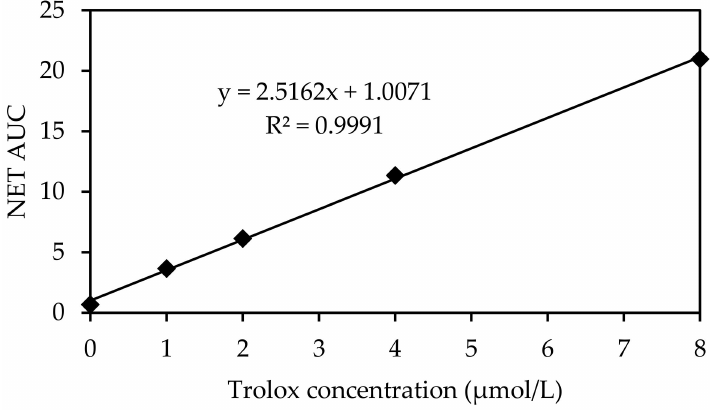
Figure A3. Calibration curve for ORAC.